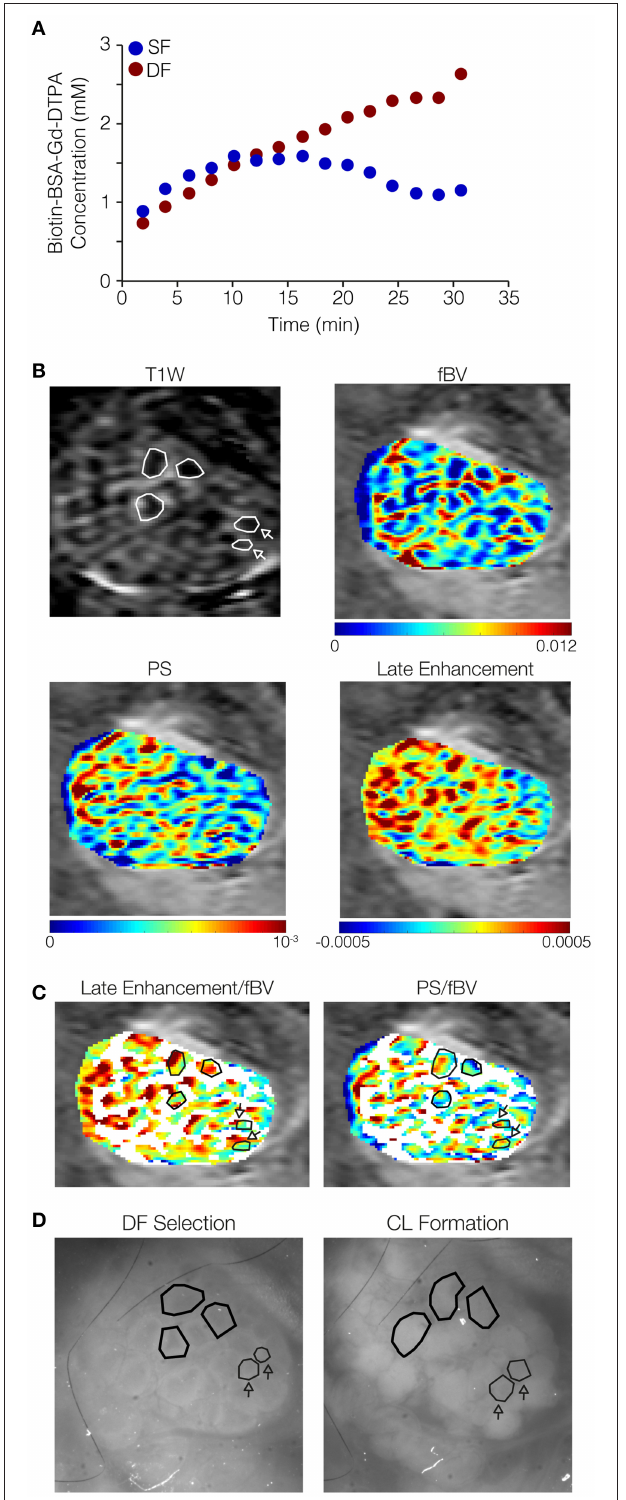
FIGURE 4 | Dominant follicles (DFs) show late signal accumulation in their antrum while subordinate follicles (SFs) do not. Ovarian follicles were imaged